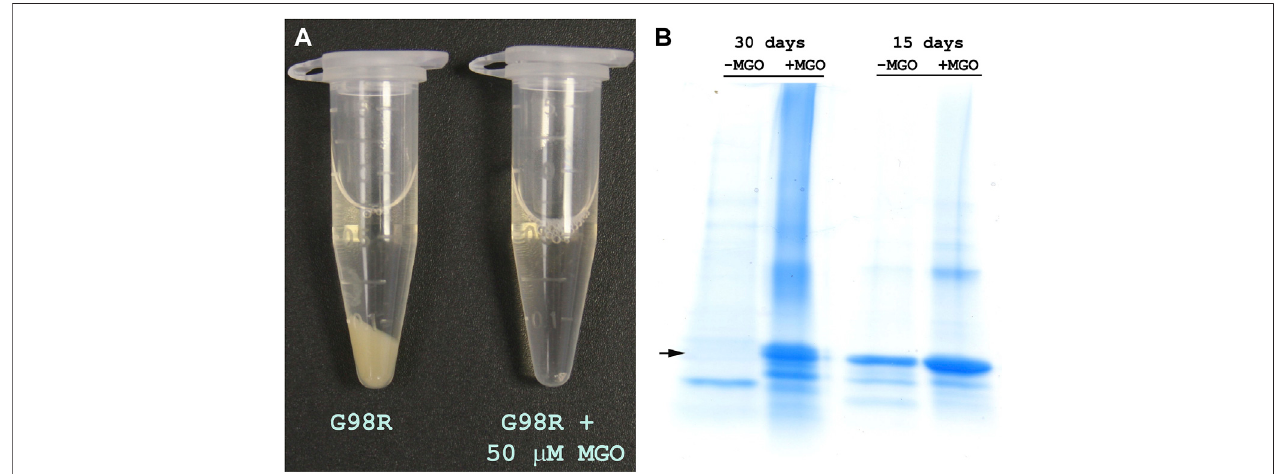
FIGURE 4 | Modi fi cation by MGO improves the stability of α AG98R protein. (A) Image of samples incubated for 30 days showing the precipitation of the mutant proteinintheabsenceofMGOandinthepresenceof50 µMMGO,thesampleremainedclear. (B) SDS-PAGEanalysisofincubationmixtureof α AG98Rinthepresence or absence ofMGO. In thesamplewithoutMGO, there wasacomplete breakdown ofthe mutant protein in30 days.Astrong band fortheintact protein wasseen inthe sample with MGO. A small amount of crosslinked and cleaved protein bands were also seen in this